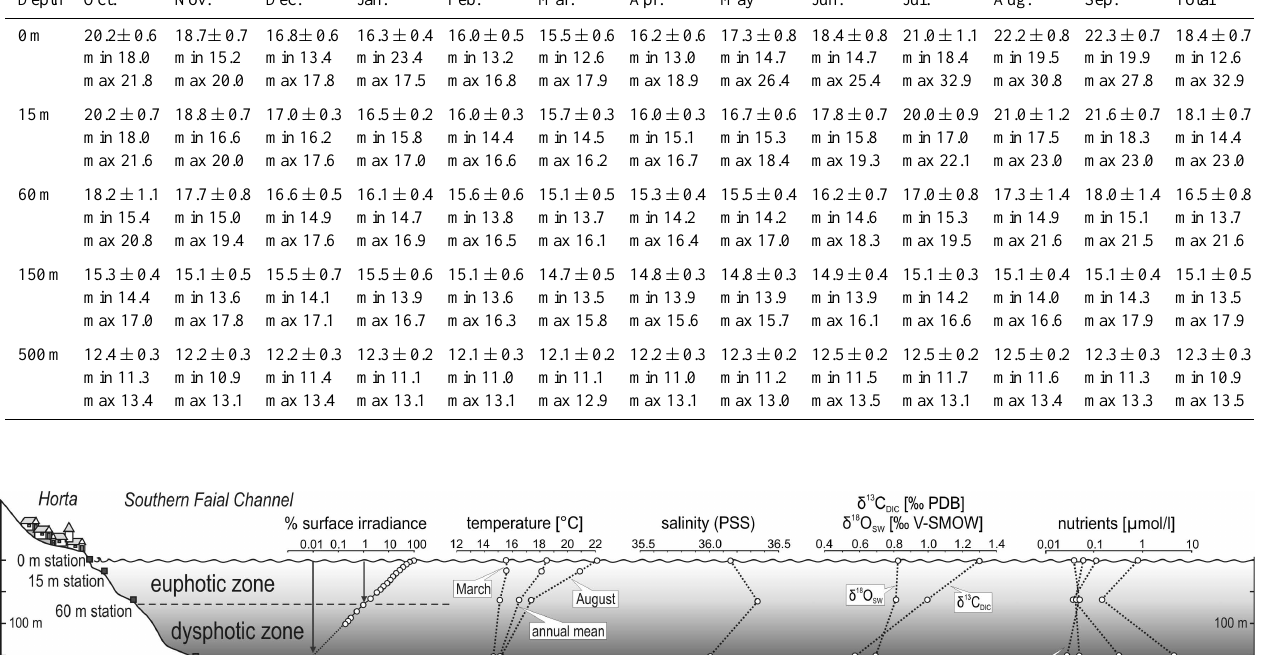
Table 1. Bottom-water temperatures (given in ◦ C as monthly and annual means ± SD, minimum, and maximum) logged via autonomous temperature loggers at the various experimental stations in 0, 15, 60, 150 and 500m water depth. Depth Oct.